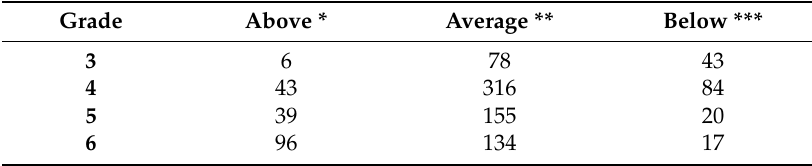
Table 2. Categorization of participants according to CAMSA ability. Grade Above *